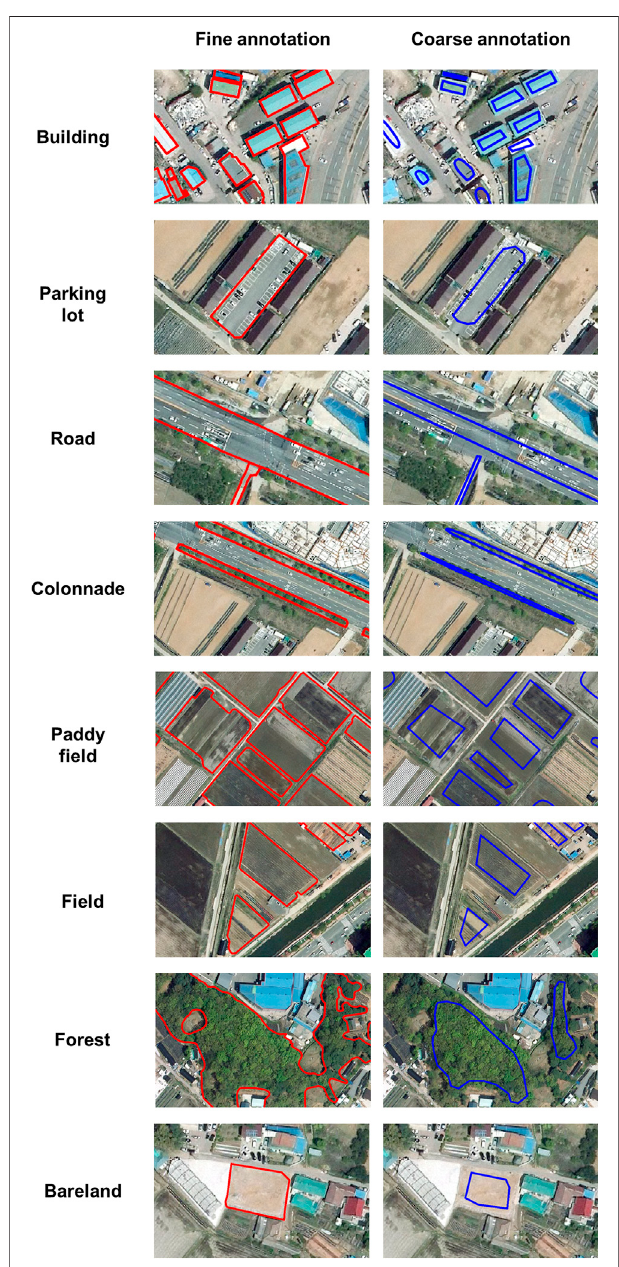
FIGURE 3 | Example of data annotation for each